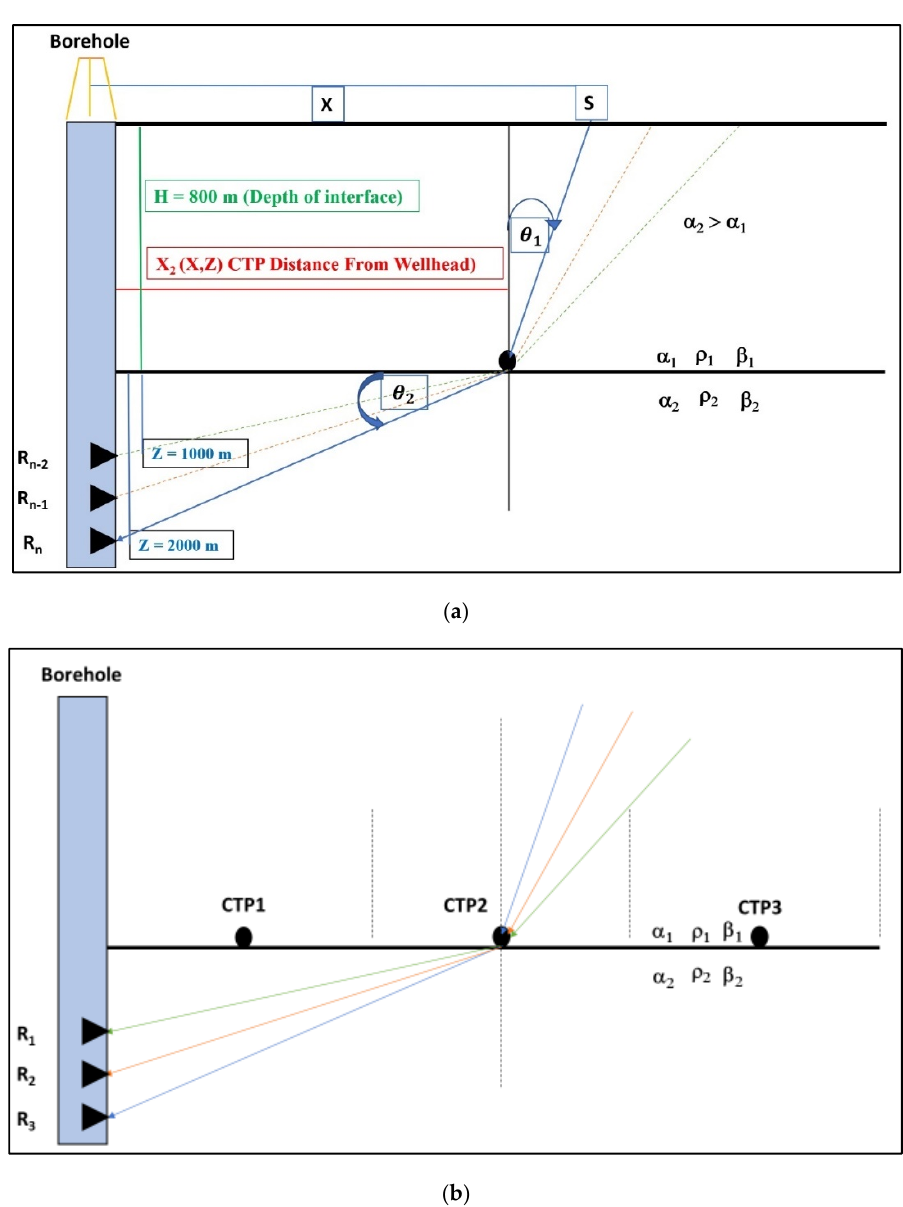
Figure 1. ( a ) CTP Configuration; ( b ) Several CTP bins with rays going through one of them.